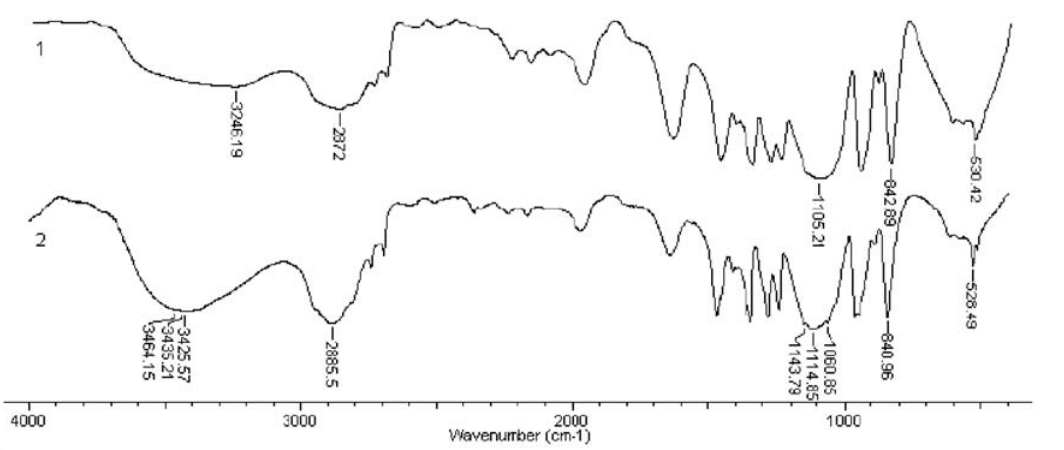
Fig. 3 IR spectra of solid PEG-rich extract without (1) and with Cd(II) plus iodide (2), extractant pH = 2.05. (Cd i = 57.05 µ g/mL, [I − ] add = 0.06